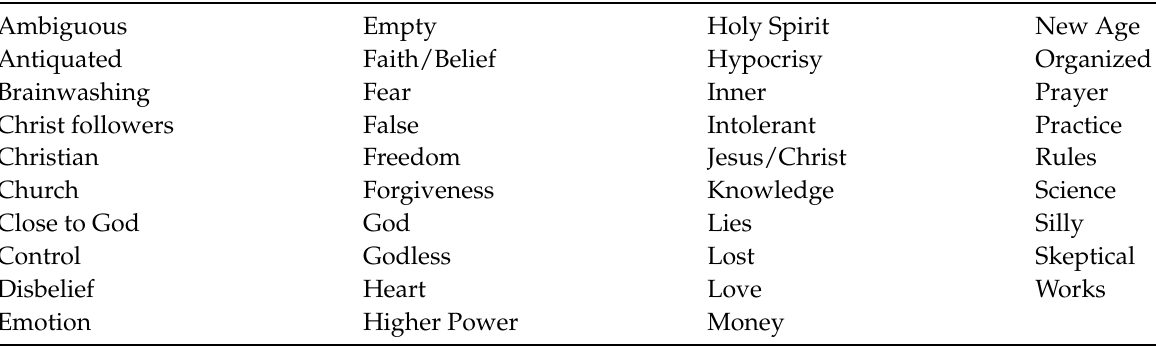
Table 1: Free list words used in timed rating exercise.